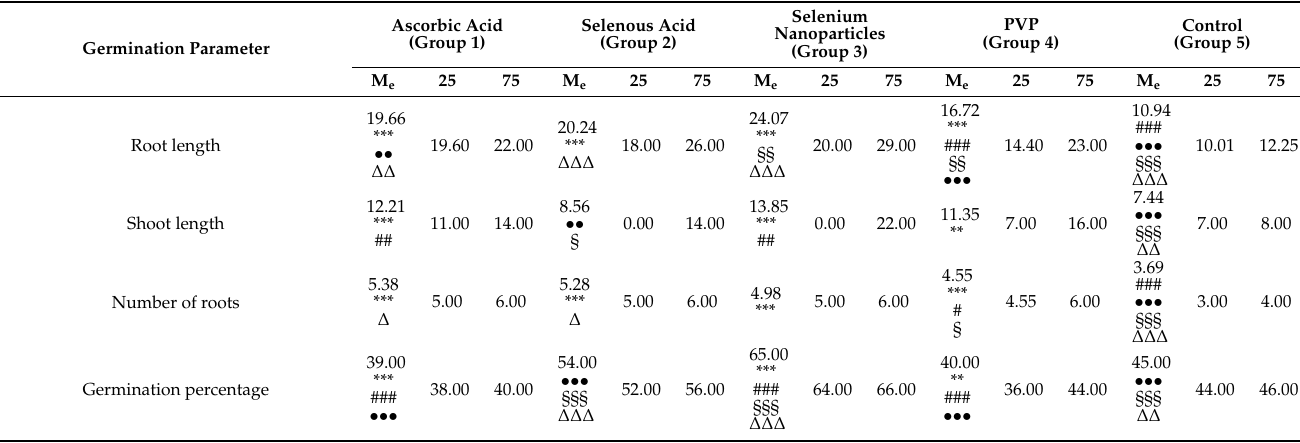
Table 4. Comparison of statistical significance of differences in morphological and functional parameters of seed germination in different groups (intergroup ANOVA results) at concentration of 4.65 µ g/mL. Ascorbic Acid (Group Germination Parameter